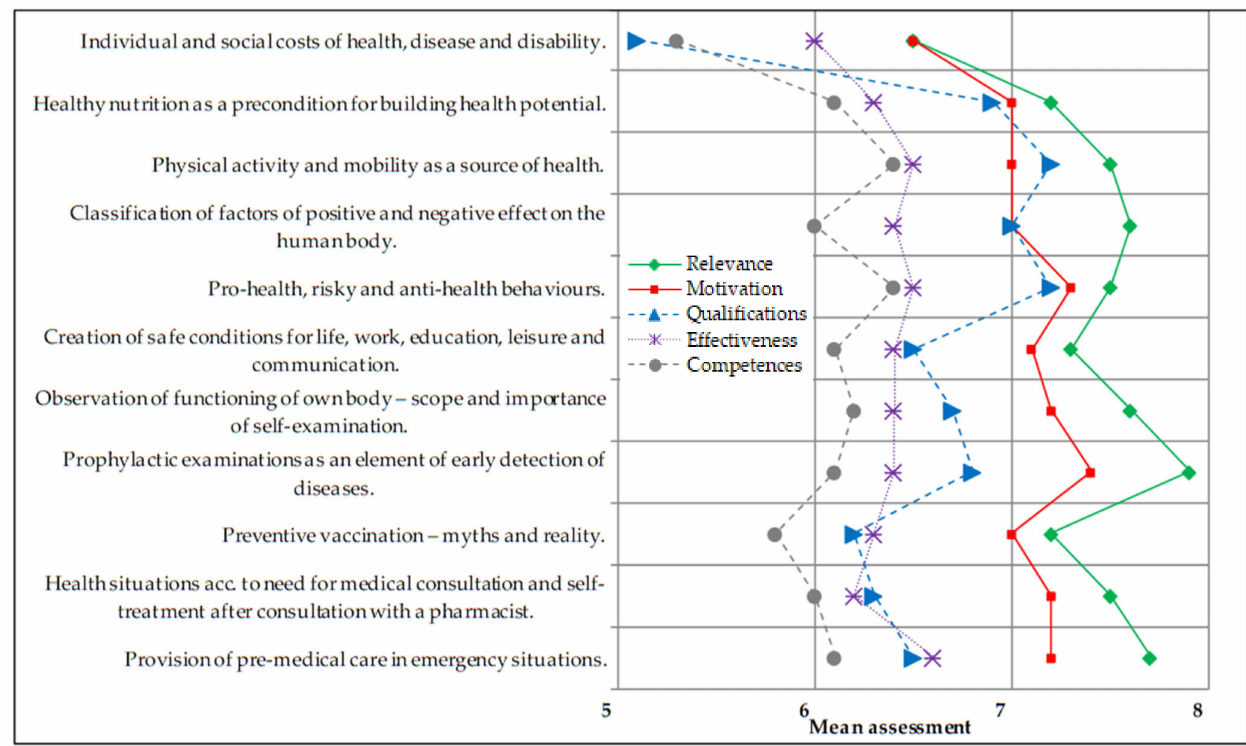
Figure 1. Pharmacy students’ mean assessment of qualifications, competences, relevance, motivation and effectiveness in health promotion— items in health knowledge (N = 206). Scale 1–10 where: 1—very low, 10—very